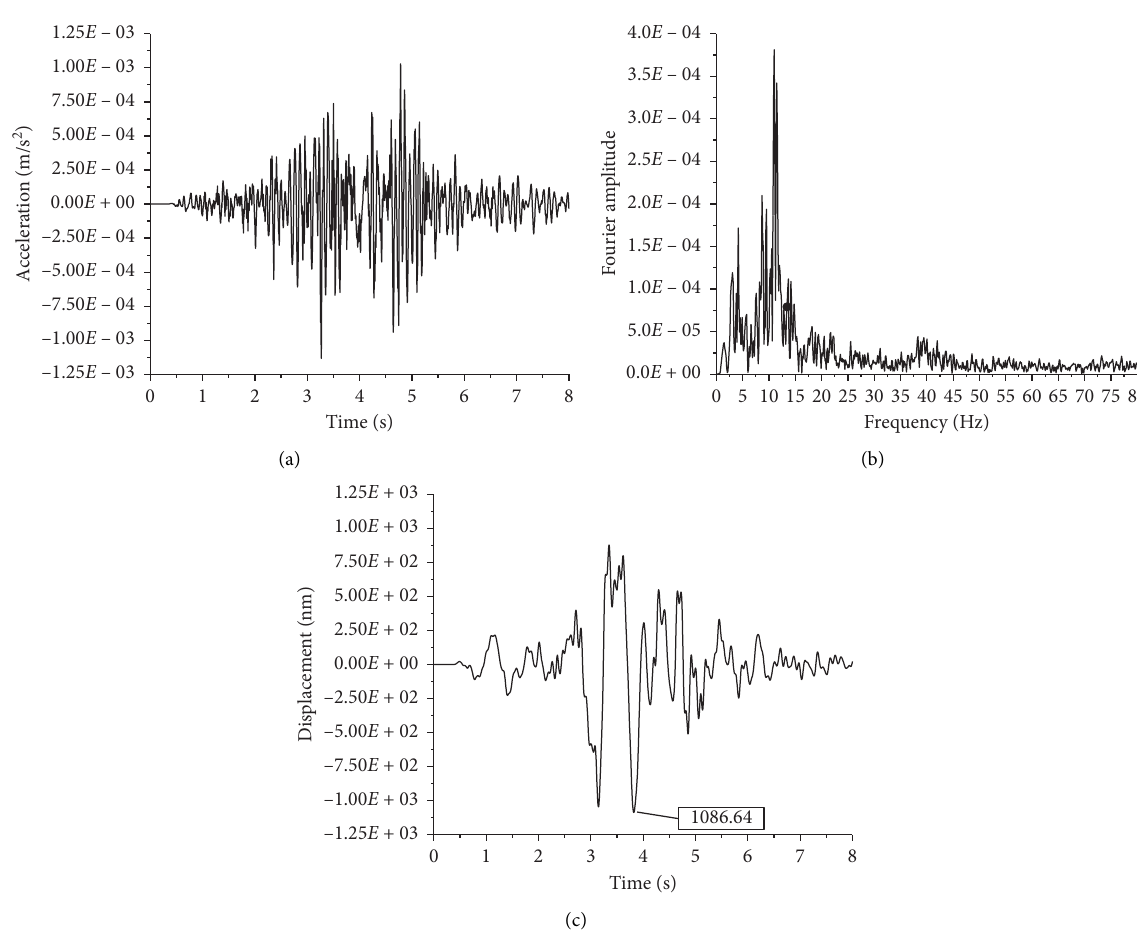
Figure 28: Numerical calculation results with no vibration-isolation measures: (a) acceleration time history, (b) frequency spectrum, and (c) displacement time